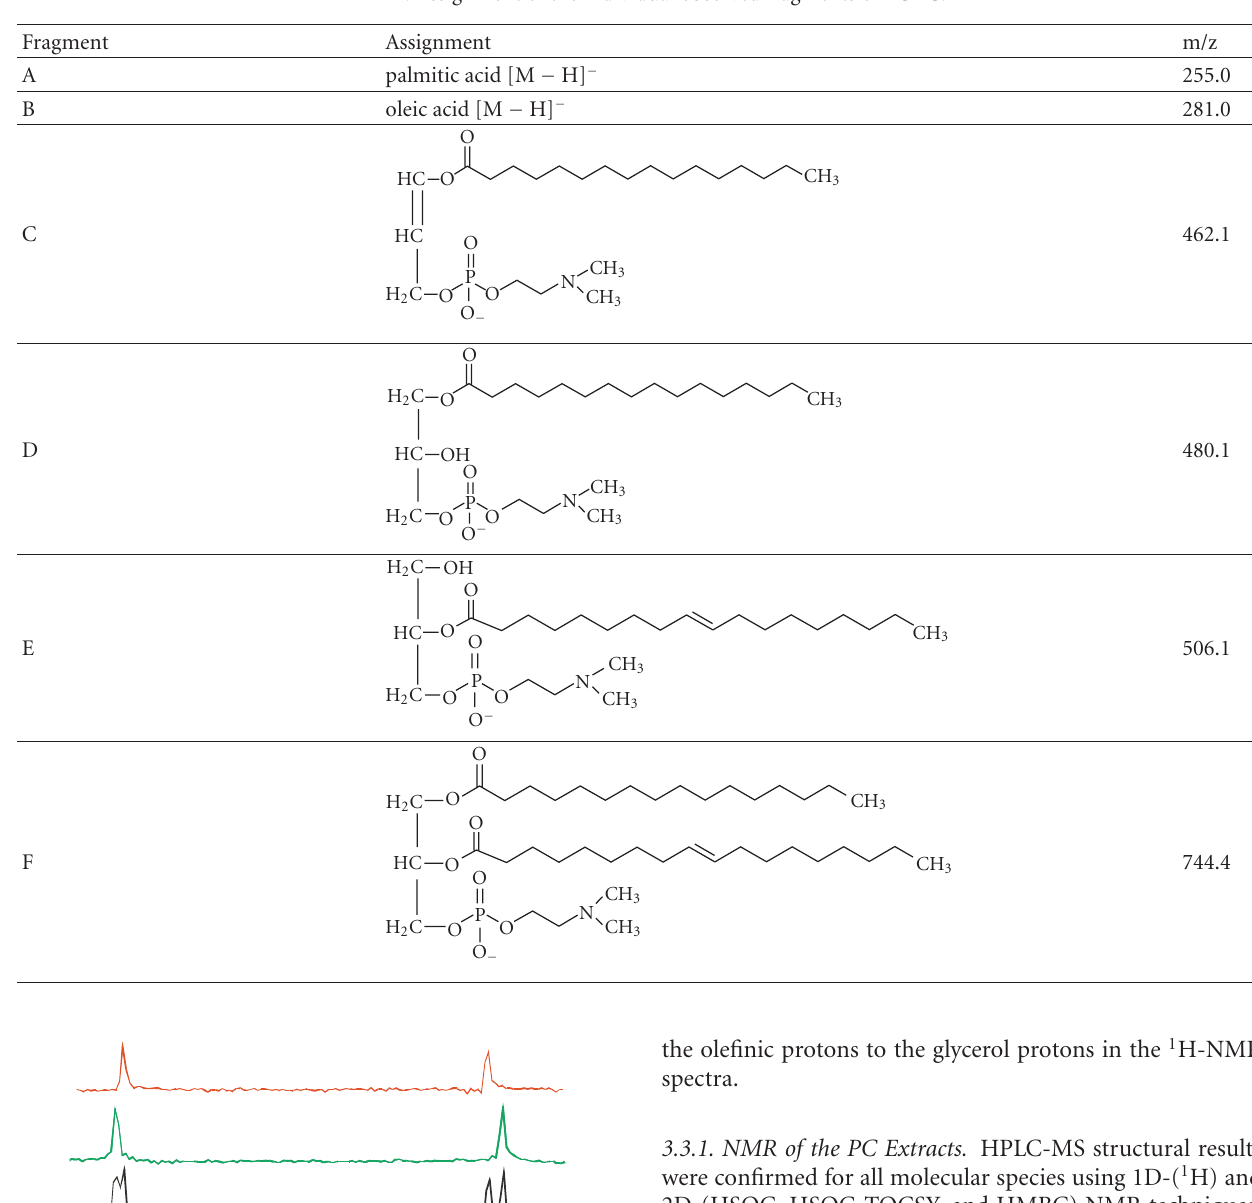
Table 4: Assignment of the individual observed fragments of POPC.